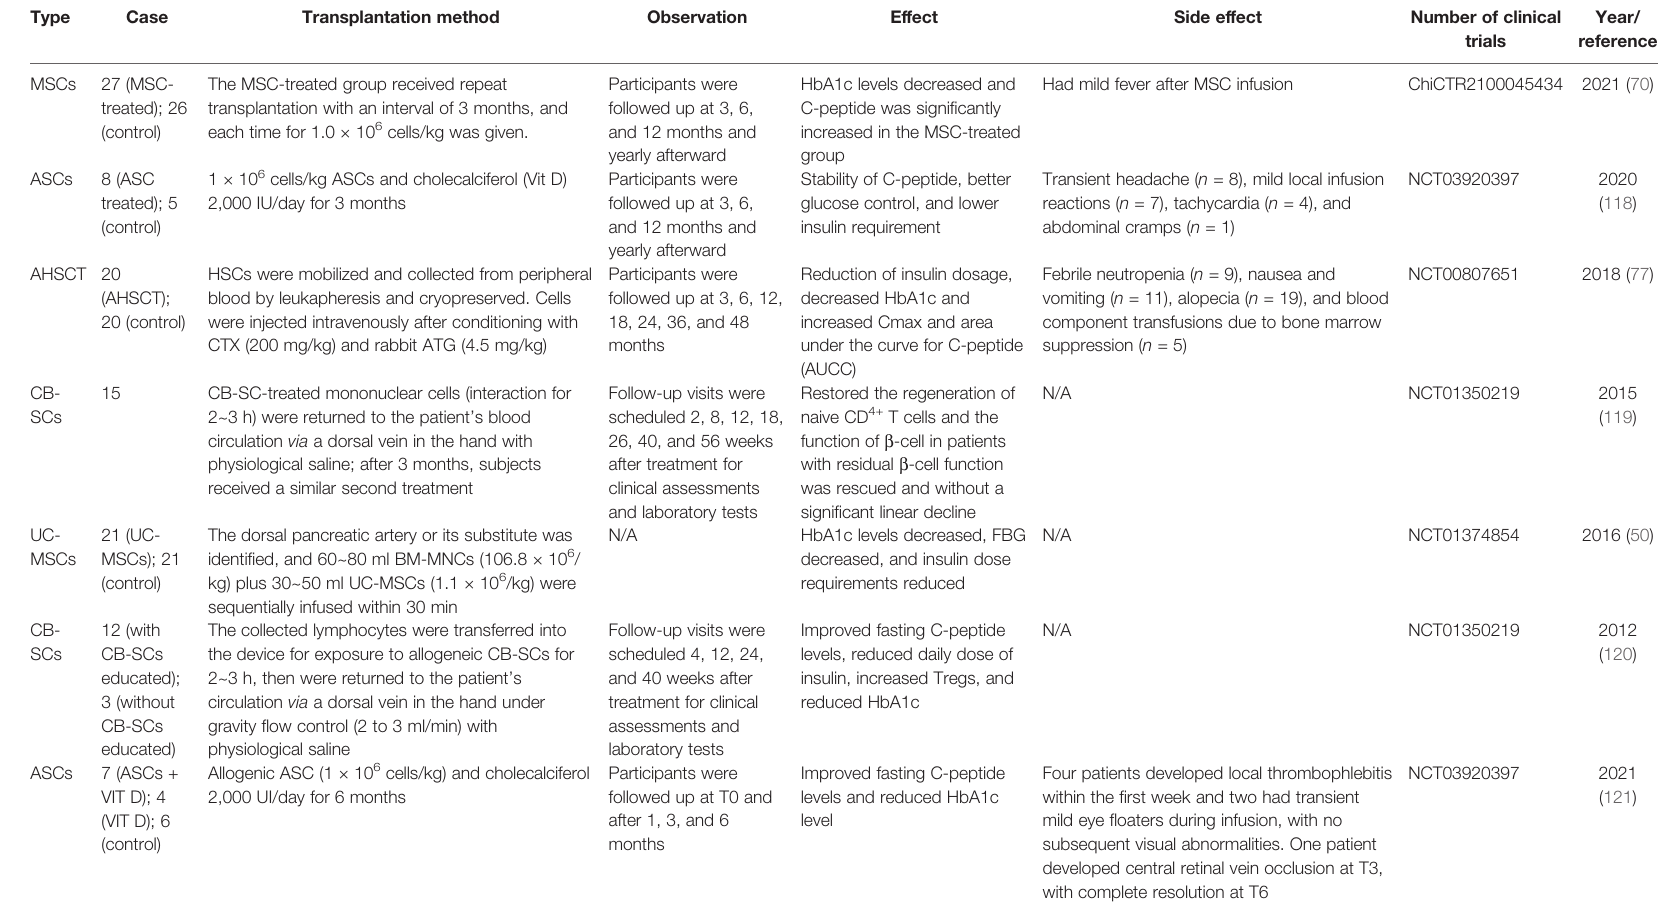
TABLE 2 | Stem cell treatment of T1DM in human clinical